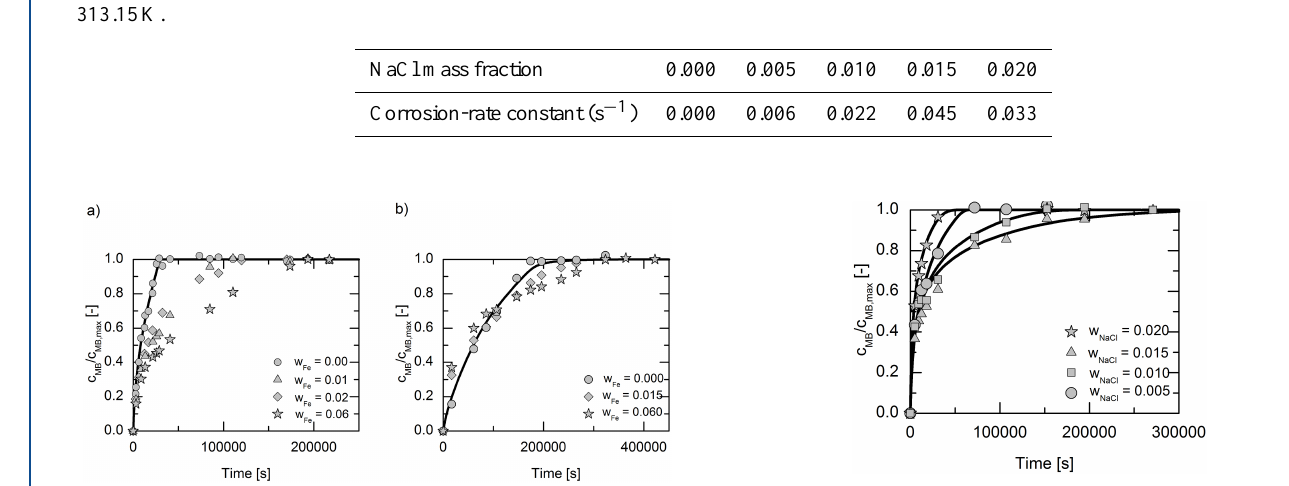
Figure 9. MB concentration profiles in PVA composite films of 180µm thickness for an iron mass fraction of 0.05 and a NaCl mass fraction between 0 and 0.02 at 80% RH and 313.15K. Symbols are experimental data and lines are modeled concentration profiles using oxygen diffusion coefficients from Table 2 and the corrosion- rate constants from Table